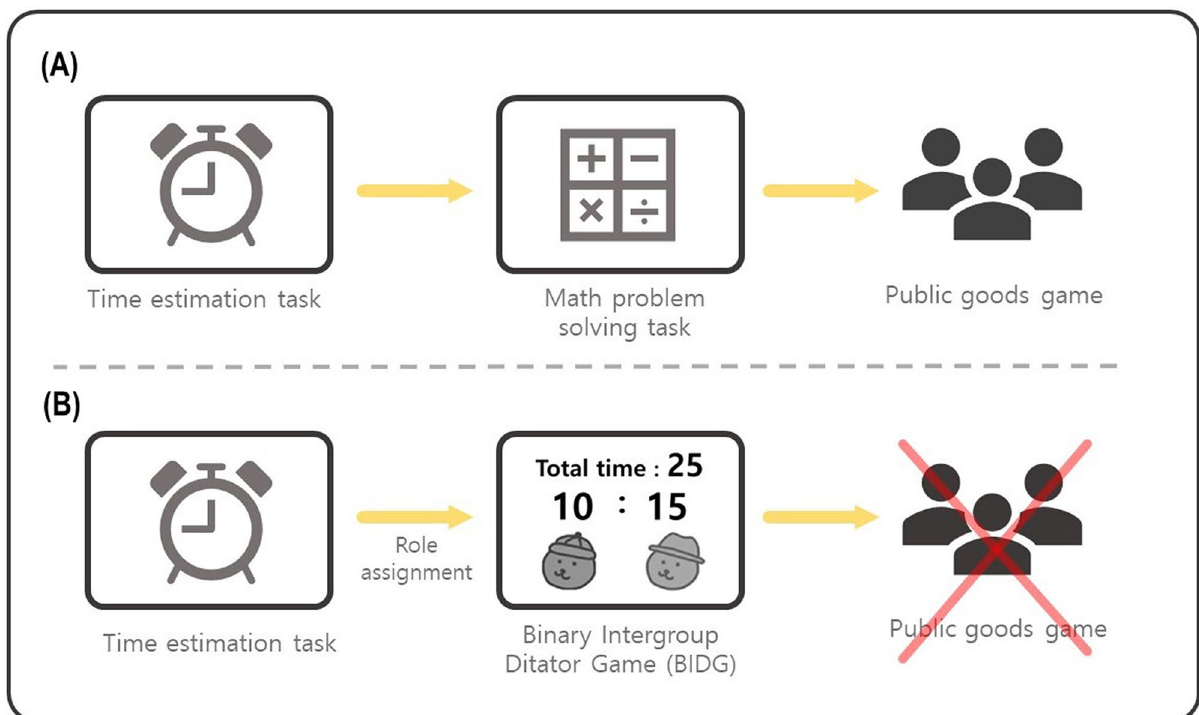
Figure 7. Schematic diagram of the experimental procedures. ( A ) In the cover story, participants were told that they would perform a time estimation task, math problem-solving task, and public goods game sequentially. ( B ) In reality, all participants were assigned to the role of the time distributor, performing the BIDG task instead, and the public goods games were not